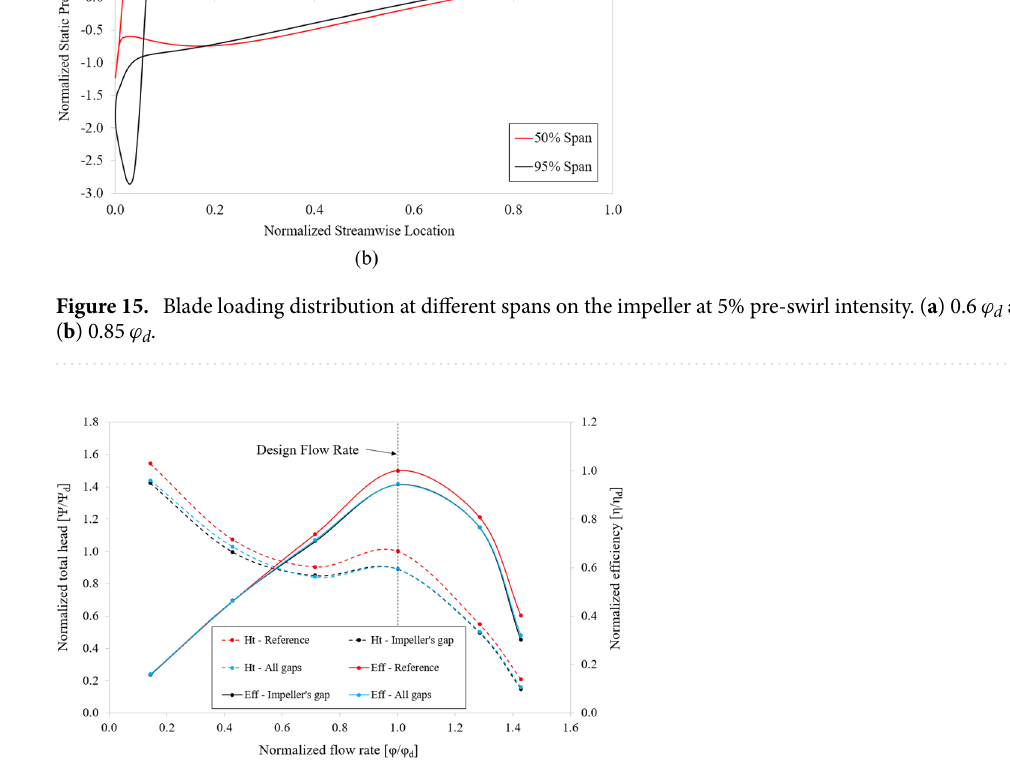
Figure 16. Hydraulic performance curves in different clearance